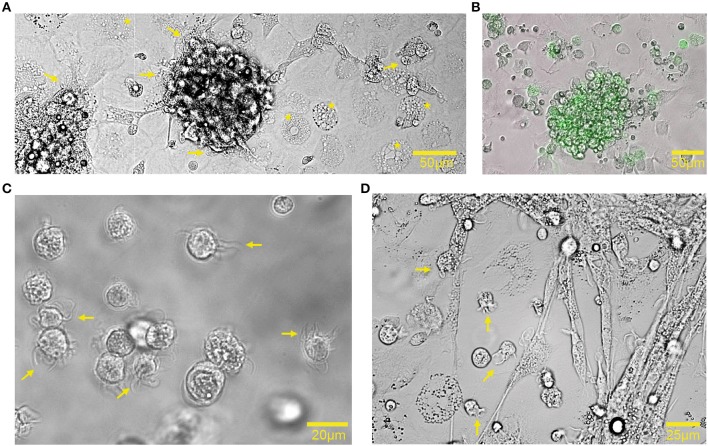
Chicken bone marrow-derived dendritic cell (chBMDC) cultures contained clusters of major histocompatibility complex class II (MHC-II)+ cells. (A) Bright-field light microscopy shows unstimulated chBMDCs after 7 days of culture. A cluster with chBMDCs is visible at the center. Yellow arrows indicate dendritic cells, visible as veiled cells that show protrusions. Yellow stars indicate highly granular cells without protrusions. (B) An overlay of light and fluorescent microscopy shows a cluster of unstimulated chBMDCs with MHC-II expression in green. (C) Light microscopy shows individual unstimulated chBMDCs that were transferred to a Petri dish after gentle resuspension in DPBS−/−. (D) Light microscopy shows lipopolysaccharide (LPS)-stimulated chBMDCs.